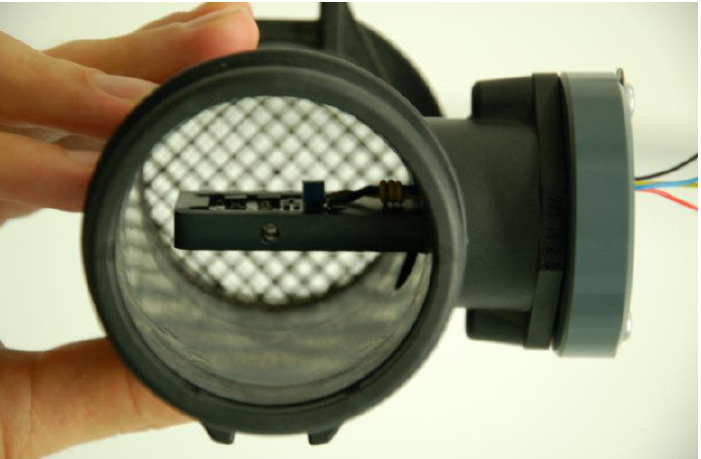
Figure 8. View of the interior of the automobile engine inlet tube with the air flow meter mounted in